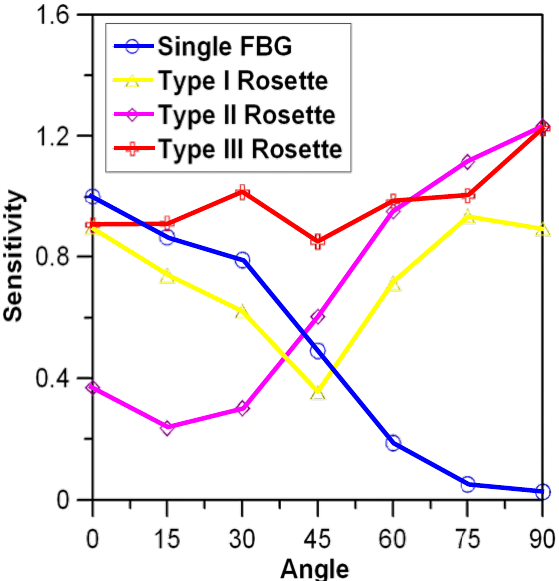
Figure 8. Sensitivity comparison between a single Fiber Bragg grating (FBG1) and different FBG rosette configurations.